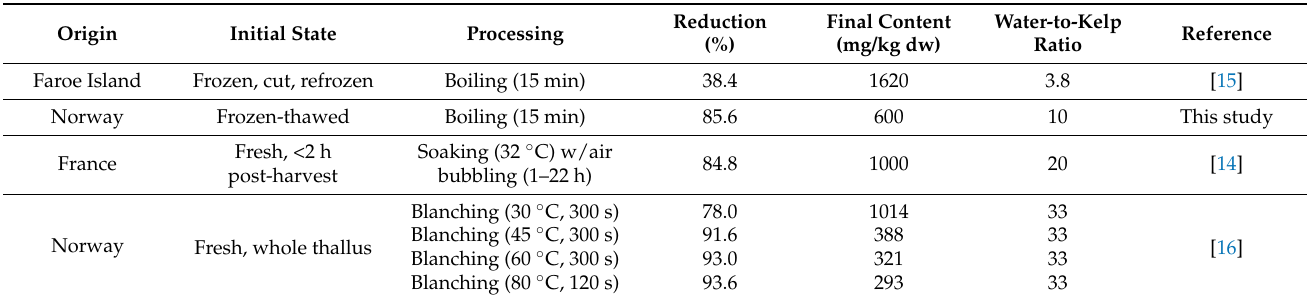
Table 4. Reduction in iodine content during processing of S. latissima at various water-to-seaweed ratios. Tap water was used in all